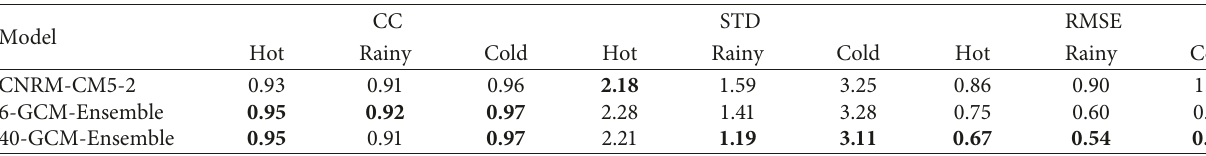
Table 5: Correlation coefficients (CCs) between observations and model simulations, standard deviations (STDs) normalized by the standard deviation of observations, and root mean squared errors (RMSEs) of average seasonal temperature for hot (FMA), rainy (MJJASO), and cold (NDJ) seasons for years 1960–1999 of CNRM-CM5-2, 6-GCM-Ensemble, and 40-GCM-Ensemble. CC STD RMSE Model Hot Rainy Cold Hot Rainy Cold Hot Rainy Cold CNRM-CM5-2 40-GCM-Ensemble 0.95 0.91 0.97 0.78 Bold face represents the best value for each performance metric.